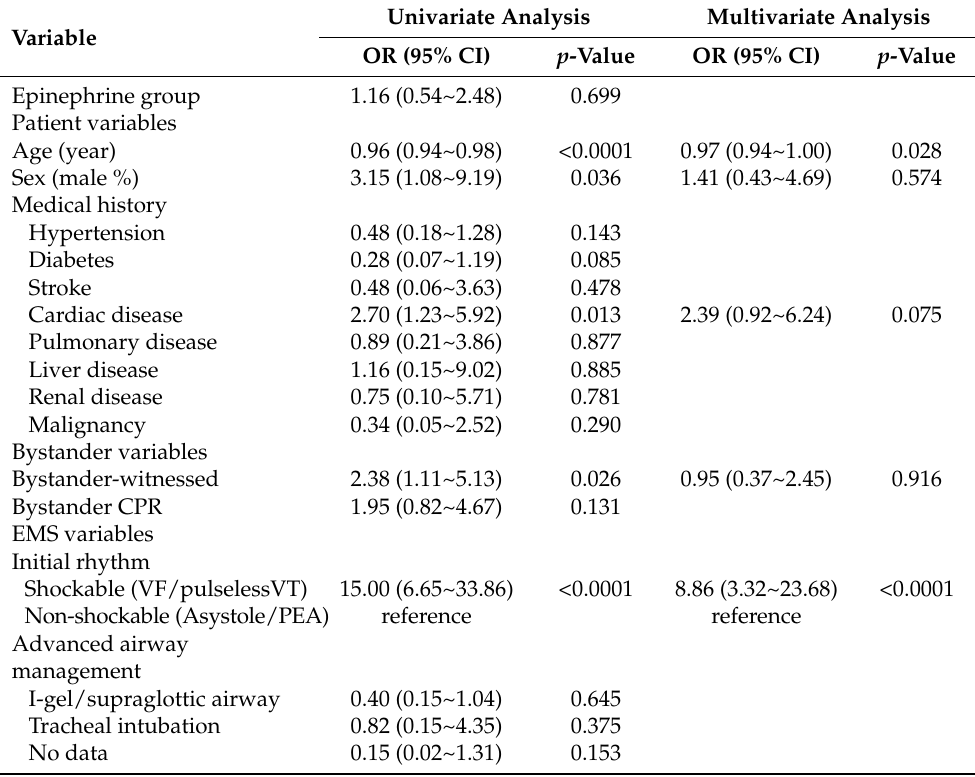
Table 4. The prognostic factors affecting survival to discharge in prehospital epinephrine administra- tion by EMS